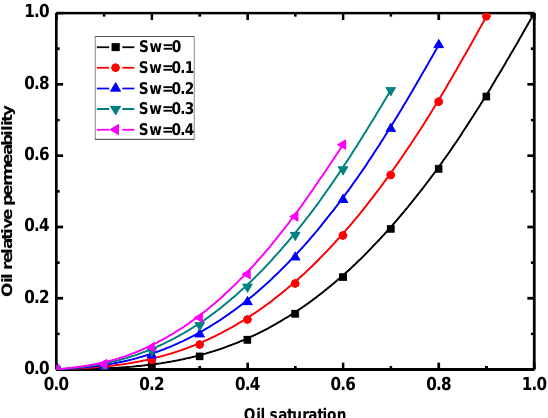
Figure 4—Oil relative permeabilities for fracture systems. The curves represent three-phase data at various water saturations when oil viscosity is 1.45 cp.